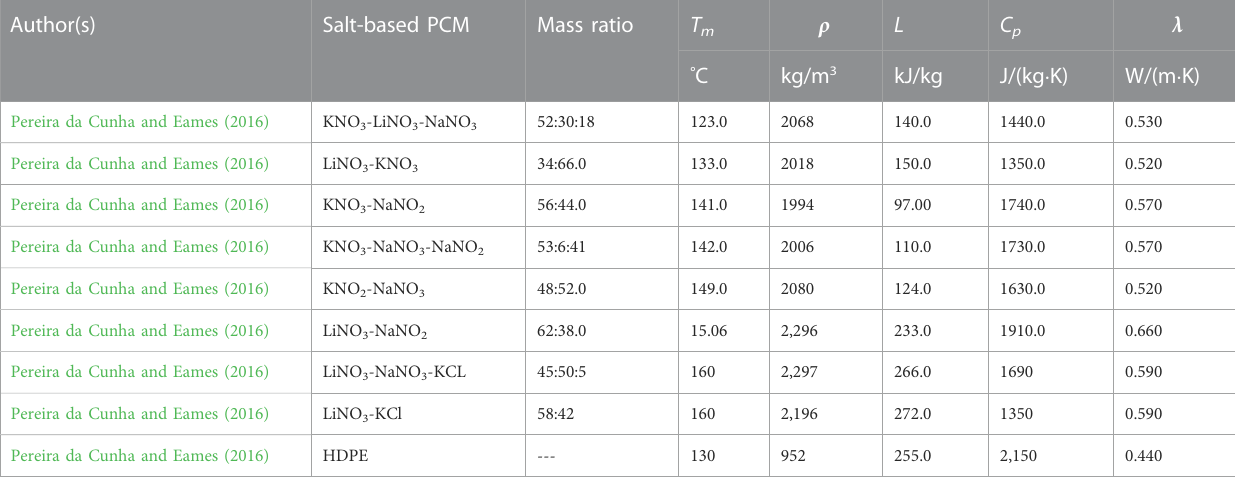
TABLE 3 Thermophysical characteristics of a few